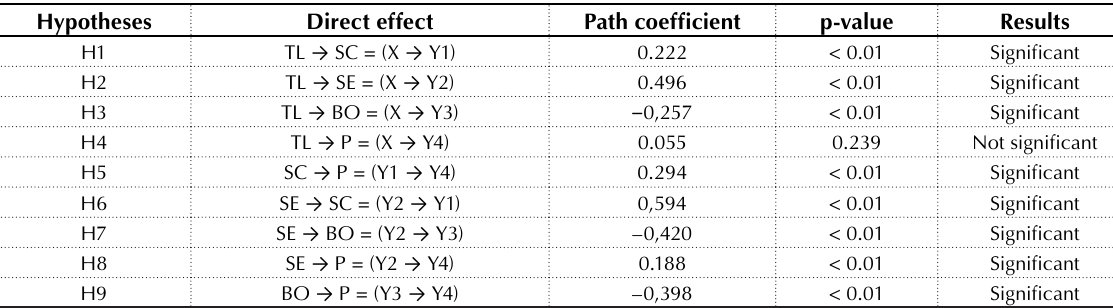
Table 1. Direct influence of path coefficient and hypotheses